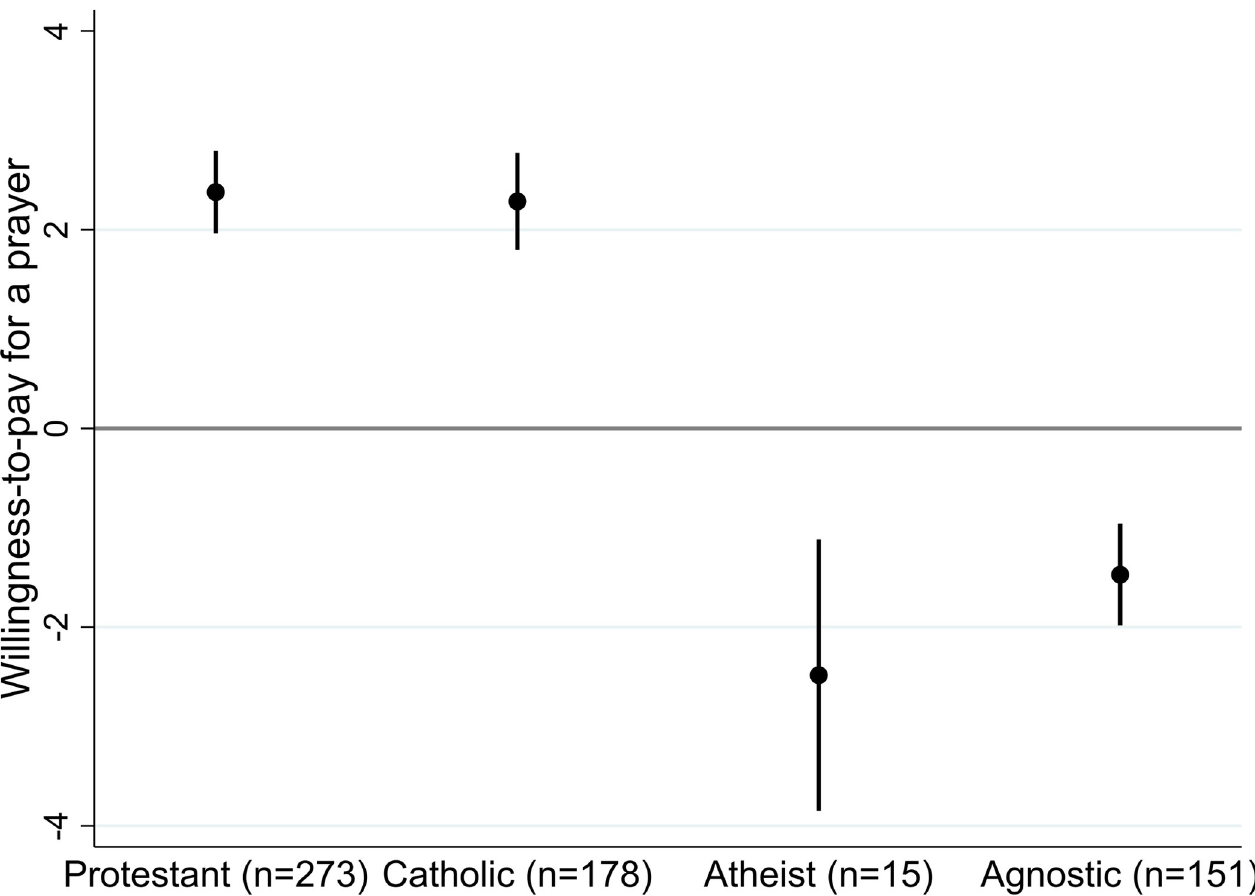
Fig 1. Mean WTP (using most conservative WTP measure) for a prayer from a Christian stranger. Note: Error bars show 95 percent confidence